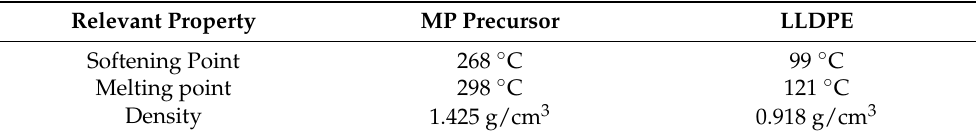
Table 1. Relevant properties of MP precursor and LLDPE.